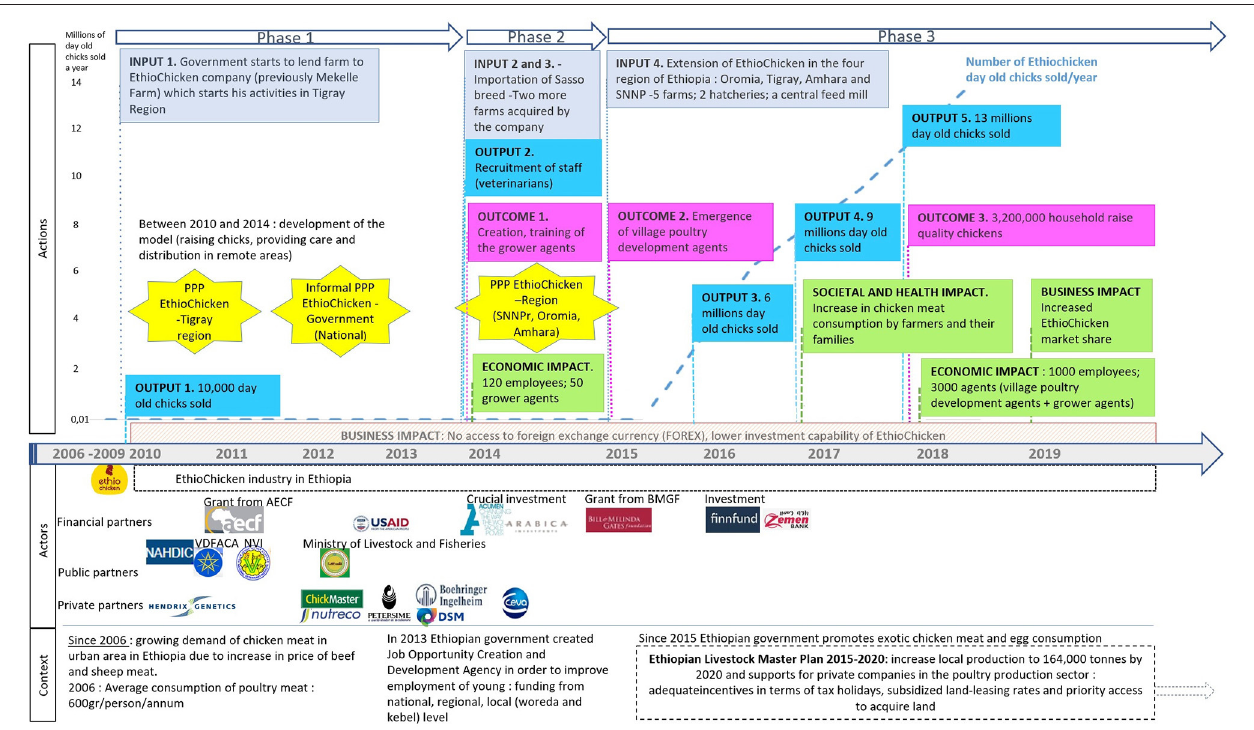
FIGURE 4 | History of the PPP development in three main phases (2010–2019) and impacts; capturing elements of context, actors, and actions. The light-blue rectangles indicate inputs, turquoise ones indicate outputs, pink ones indicate outcomes, and green ones indicate positive impacts and red ones negative impacts. The stars indicate the building of PPPs at national level (second star) and regional level (first and third stars). The actors represented are the financial partners, who have invested in the company EthioChicken, the public partners, and the other private partners. The elements of context are given at the bottom of the figure. The Ministry of Livestock and Fisheries was merged with Ministry of Agriculture since April 2018. AECF, Africa Enterprise Challenge Fund; BMGF, Bill and Melinda Gates Foundation; NAHDIC, National Animal Health Diagnostic and Investigation Center; Forex, Foreign Exchange Currency; NVI, National Veterinary Institute; PPP, Public–Private Partnership; SNNPr, Southern Nations, Nationalities and Peoples’ region; VDFACA, Veterinary Drug and Animal Feed and Administration Control Authority; USAID, United States Agency for International